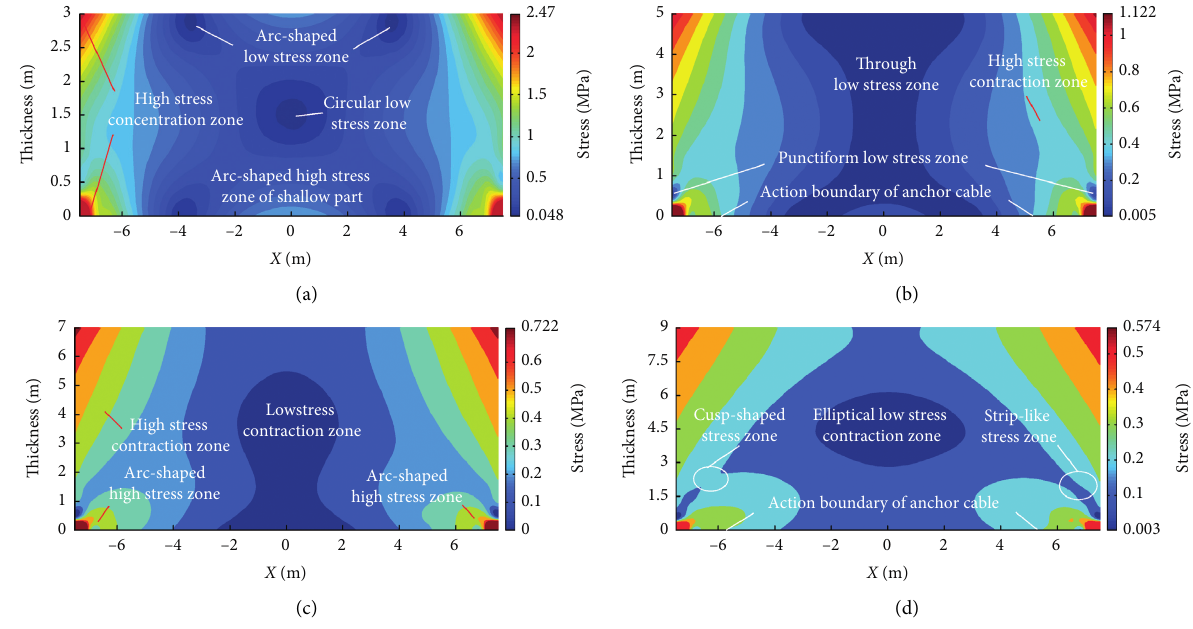
Figure 8: MSS distributions with different ARBBS thicknesses. (a) h � 3 m, (b) h � 5 (m), (c) h � 7 (m), and (d) h � 9 m.